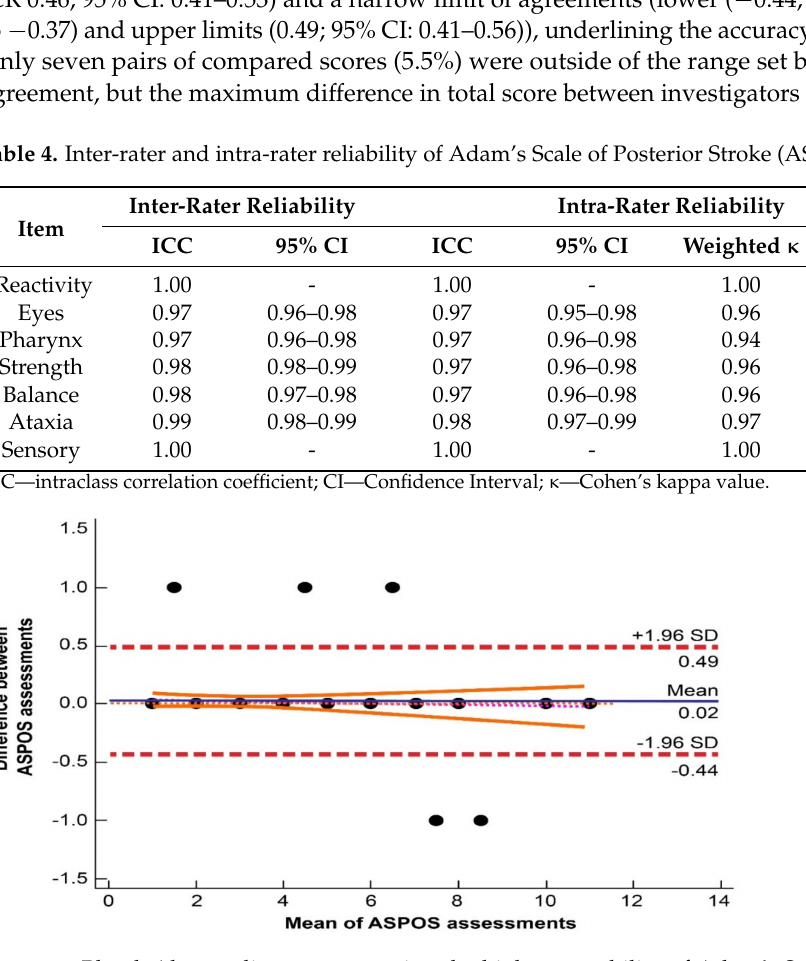
Figure 1. Bland–Altman diagram presenting the high repeatability of Adam’s Scale of Posterior Stroke (ASPOS).The distribution of points (black plots) is based on the mean and the difference from the total ASPOS score obtained by two randomly selected researchers. The area between the dashed red lines indicates the limits of agreement. The mean of the limits of agreement is presented as a blue line. The area between the solid orange lines represents the 95% confidence interval of the regression line (a line composed of red